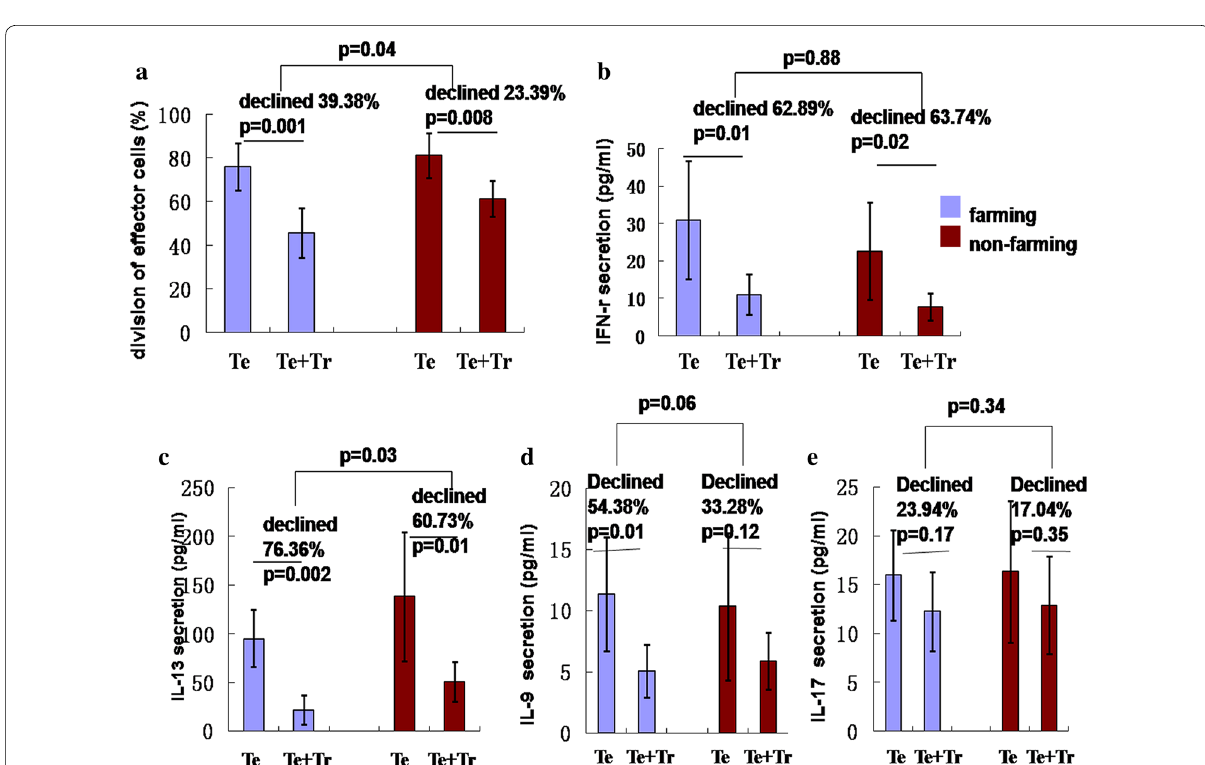
Fig. 6 Suppressive action of CD4 CD25 T reg cells on the division of Th cells. a The suppressive action of Tregs on the division of effector + + T cells; b – e the suppressive action of Tregs on the production of IFN-γ, IL-13, IL-9, and IL-17 in effector T cells. Te: CD4 CD4 CD25 T regulatory T cell (n 8). The values are represented as mean SEM. T-test was used to compare the farming and non-farming + + = ± groups. Statistical significance is indicated by P values < 0.05. n =